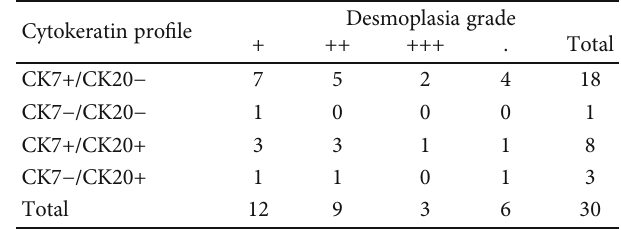
Table 3: Specimens lacking correlation between morphological type and immunohistochemical fi ndings.